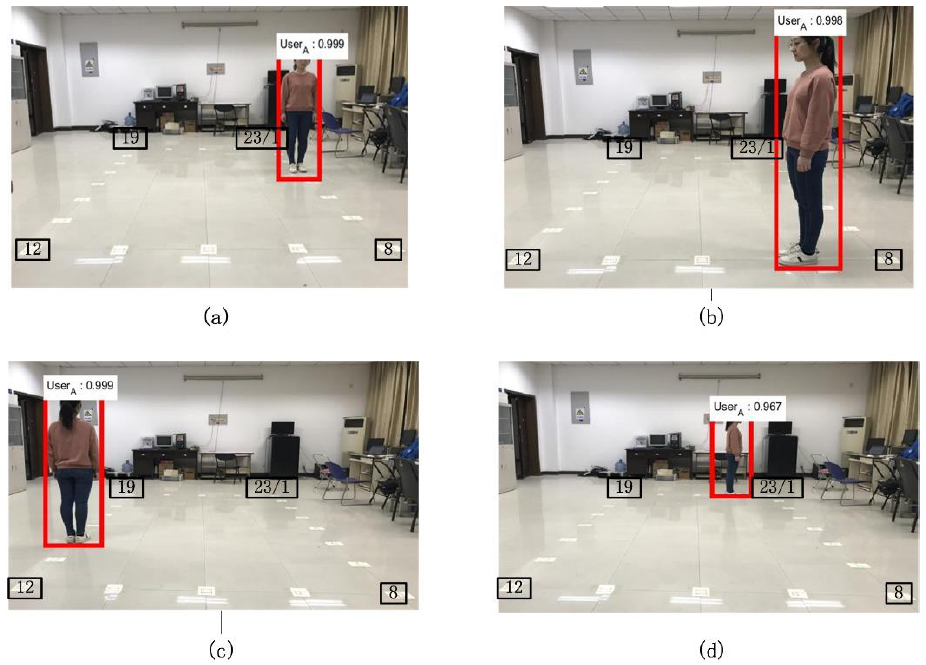
Figure 6. A person captured in four phases. ( a ) phase 1, marker 1–8th; ( b ) phase 2, marker 9–12th; ( c ) phase 3, marker 13–19th; ( d ) phase 4, marker 20–23th.